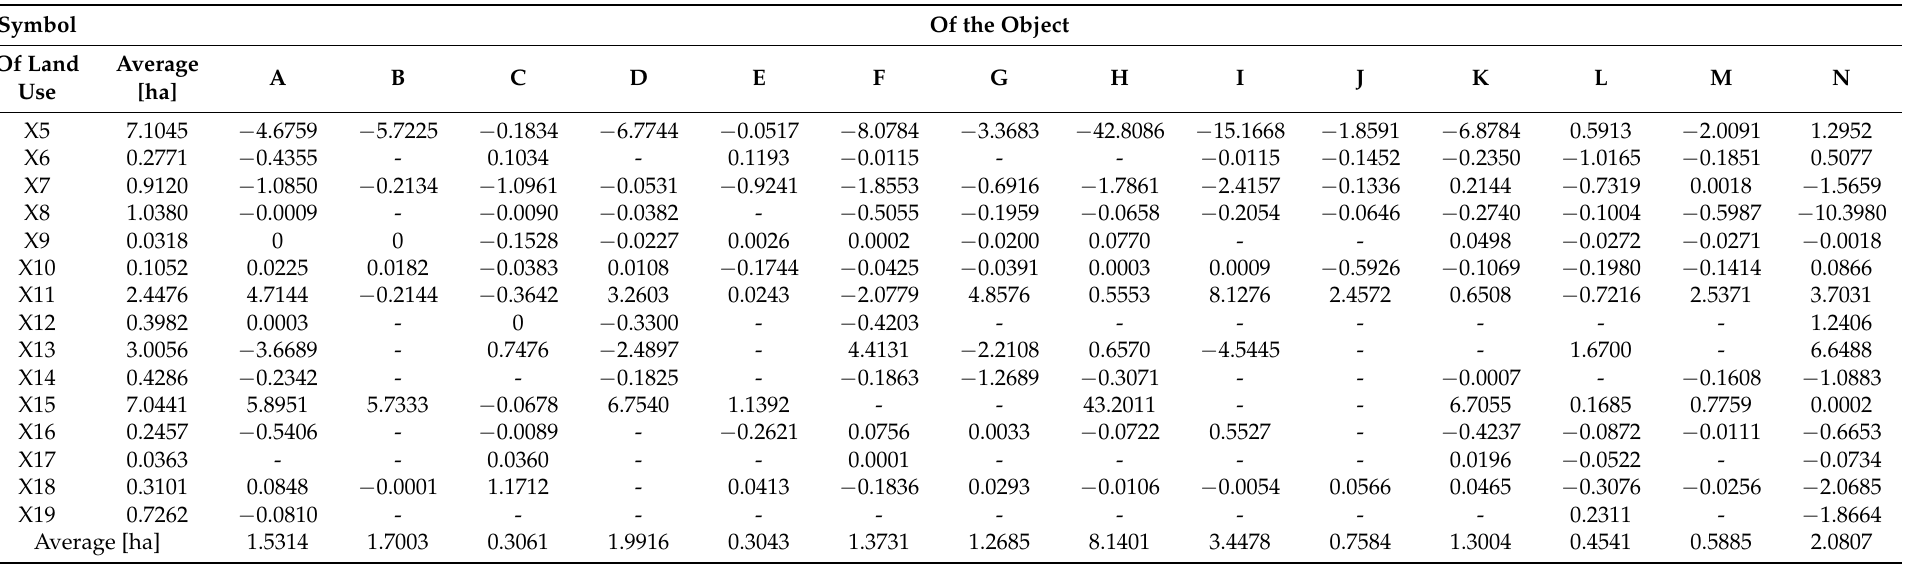
Table 2. Absolute changes in land use areas after cadastral data modernisation in all the objects under